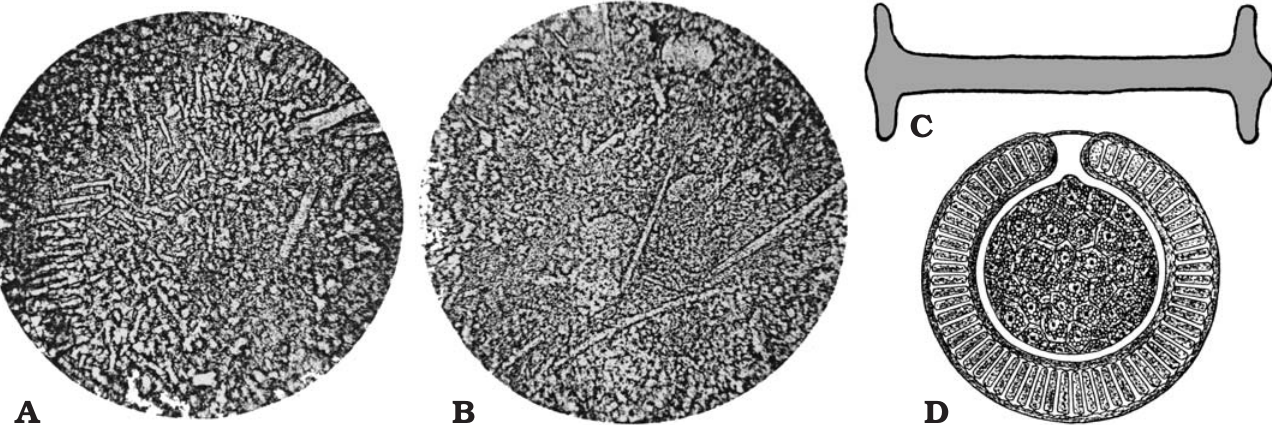
Fig. 15. Ephydatia kaiseri Rauff, 1926, Spongillida: Spongillidae; (pre) middle Eocene freshwater chert, Pomona diamond field, Namib Desert, Namibia. A . Grouped gemmuloscleres; originally enlarged 660×, the text states that particular birotules are 44–65 μ m long. B . Megascleres; originally enlarged 175, the text states that spicules are 350 μ m long. C . Birotule (gemmulosclere), originally enlarged 660×, the text states that spicule can be 44–65 μ m long. D . Gemmule of a Recent species of Ephydatia (cross section). A, B, photographs; C, D, schematic drawings. Modified from Rauff